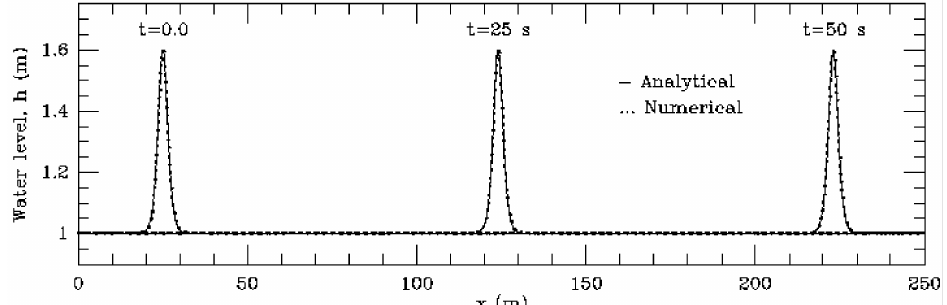
Figure 3. Propagation of a solitary wave with a / h 0 = 0.60. Comparison of the analytic solutions in Equations (32) and (33) ( _____ ) with the numerical results ( · · · · · · ) of the Serre model in Equation (12) with α = β =